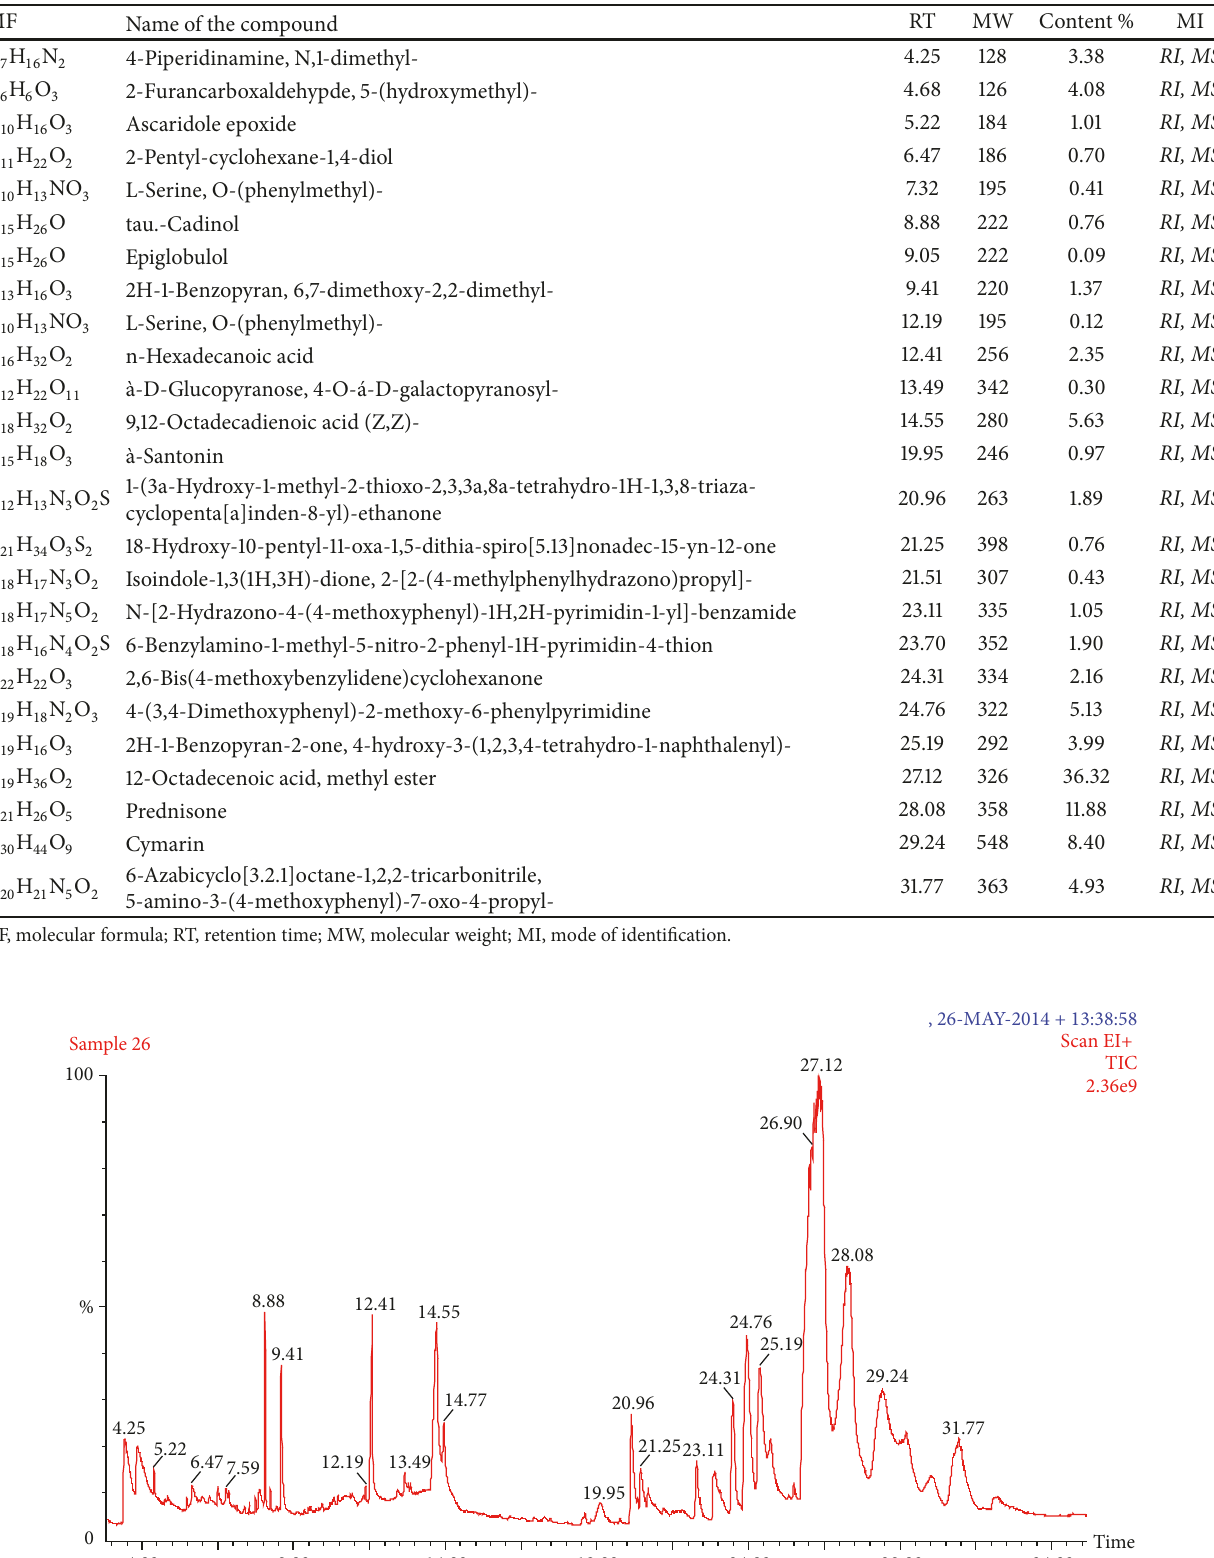
Table 3: Phytochemical components identified in the leaf powder sample (Code No. 26) (GC MS study).